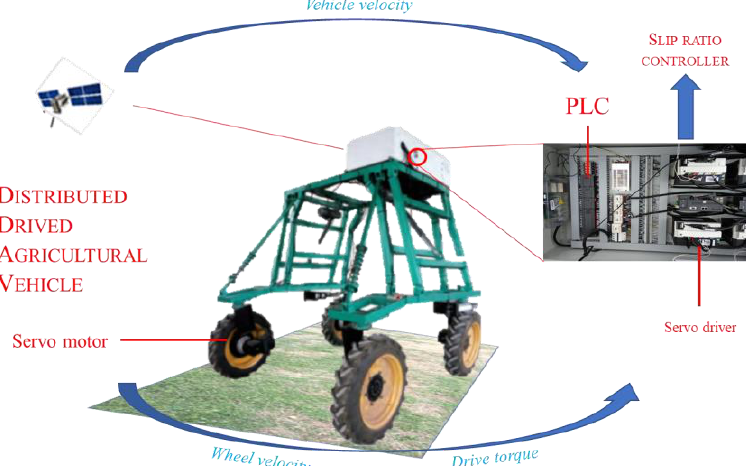
Figure 2. Hardware structure of the DDAV.